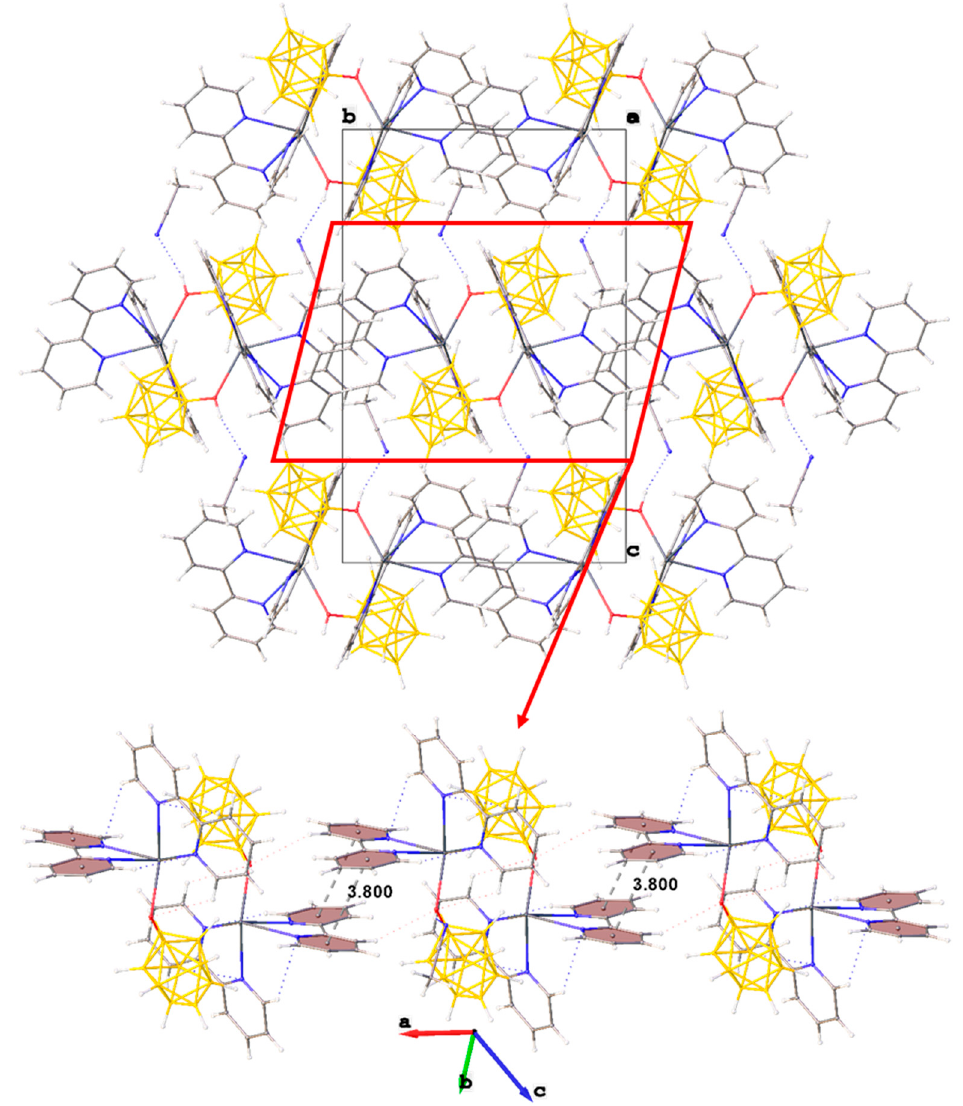
Figure 2. Packing diagram of 1 · CH 3 CN and π – π stacking interactions in the crystal. The crystallographically independent part of the triclinic unit cell of 2 · 0.5bipy · CH 3 CN (Figure 3a) contains the complex molecule [Pb(bipy) 2 [B 10 H 9 O(CH 2 ) 2 O(CH 2 ) 2 OH]], half of the bipyridyl clathrate molecule, and one acetonitrile molecule. The coordination environment of lead includes four N atoms from two bipyridyl molecules, three O atoms from the exopolyhedral substituent of the [B 10 H 9 O(CH 2 ) 2 O(CH 2 ) 2 OH] 2 − anion, and the B6B9 edge. The Pb–X distances are given in Table 2. On the Hirschfeld surface of the